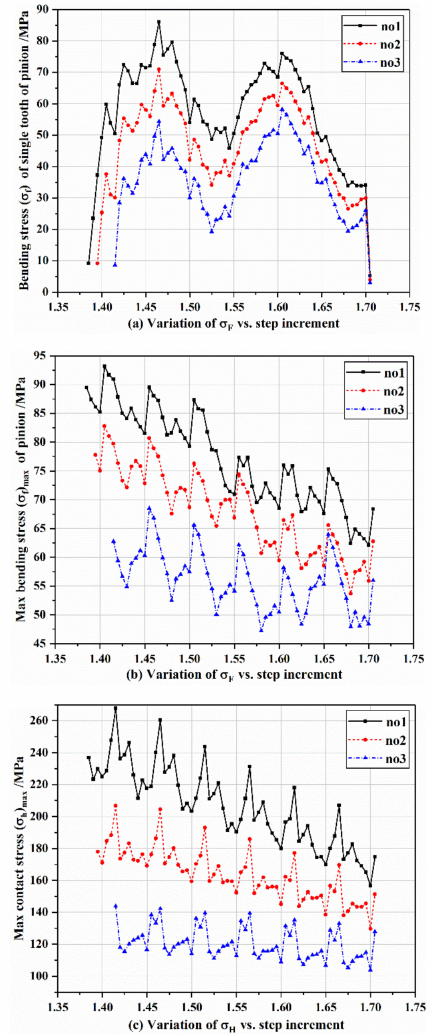
Figure 12. Influence of deflection angle on bending and contact stresses. ( a ) Bending stress of single tooth of pinion. ( b ) Maximum bending stress of pinion. ( c ) Maximum contact stress of